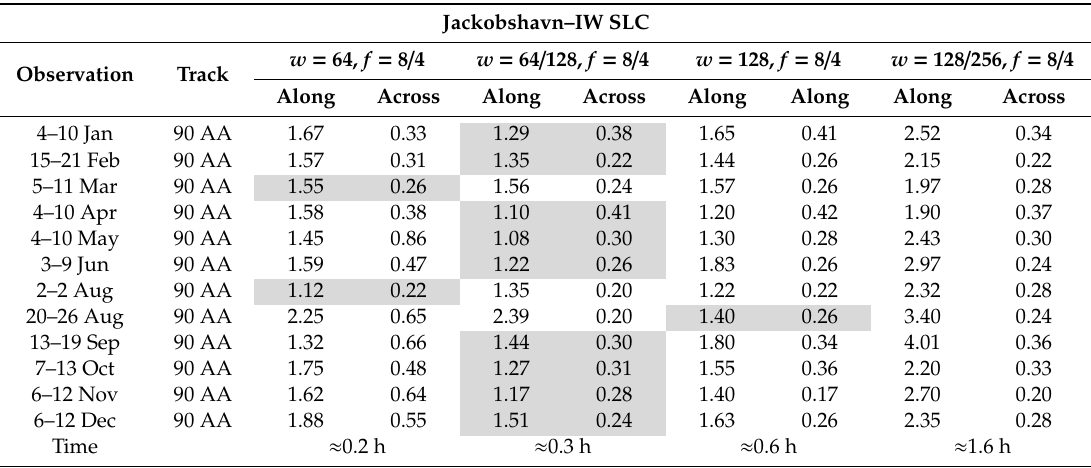
Table 8. JAK, IW SLC product class experiments, RMSE (expressed in m / day) with respect to available literature data measured along selected along / across flow transects.